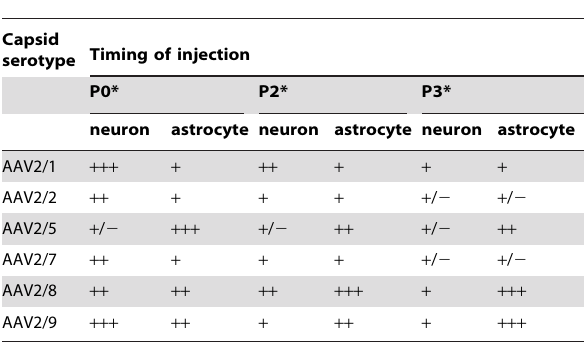
Table 2. Comparative summary of the effect of AAV capsid serotype and timing of injection on cellular tropism and intensity of EGFP expression in neonatal